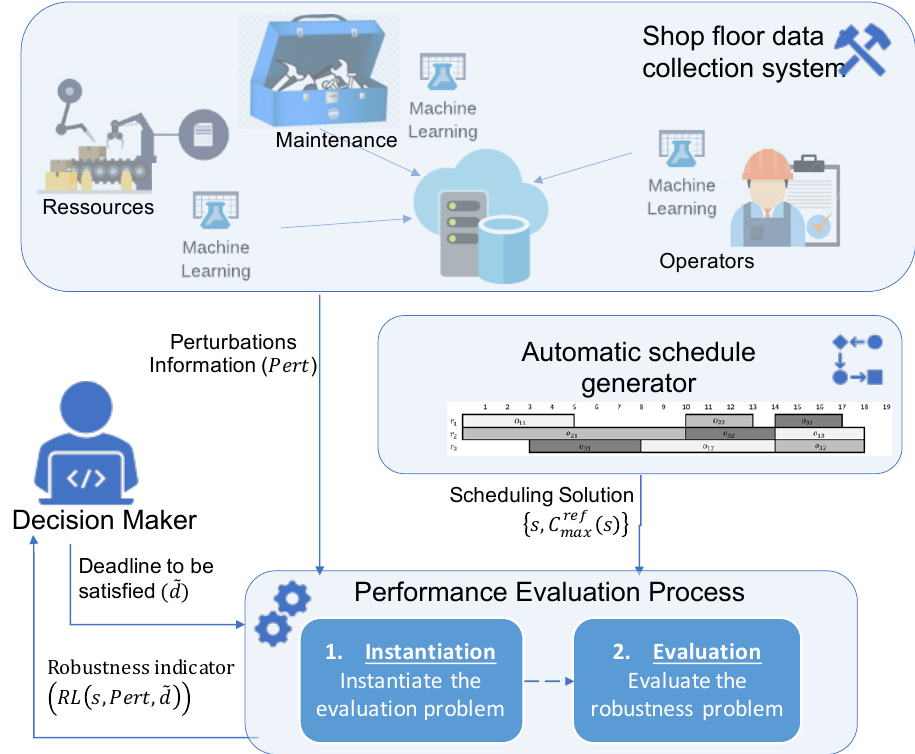
Figure 3. Robustness evaluation